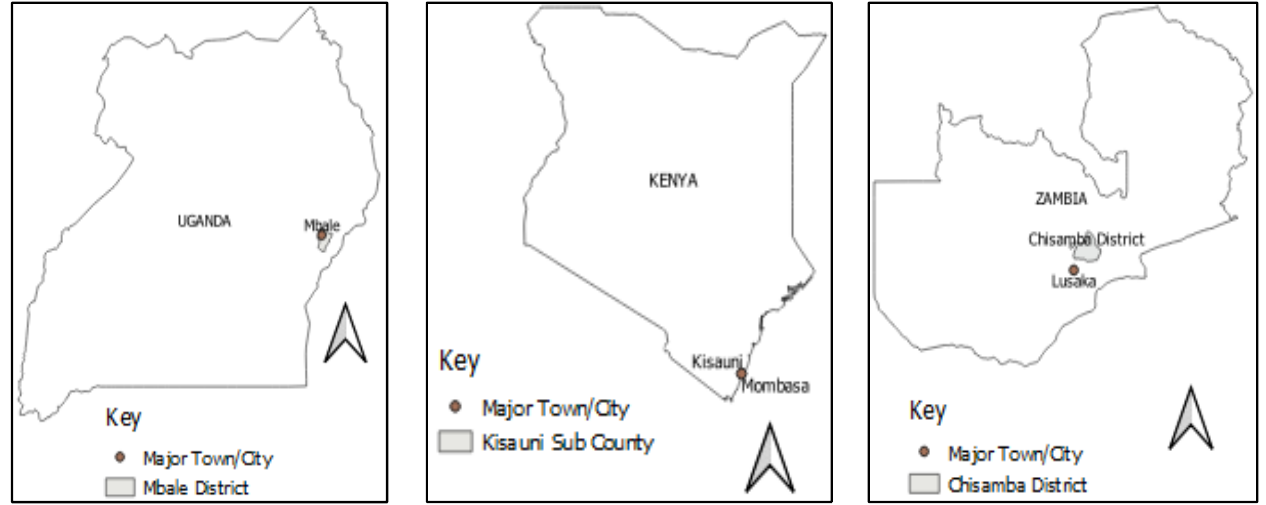
Figure 2. STDM case studies area in the three countries.